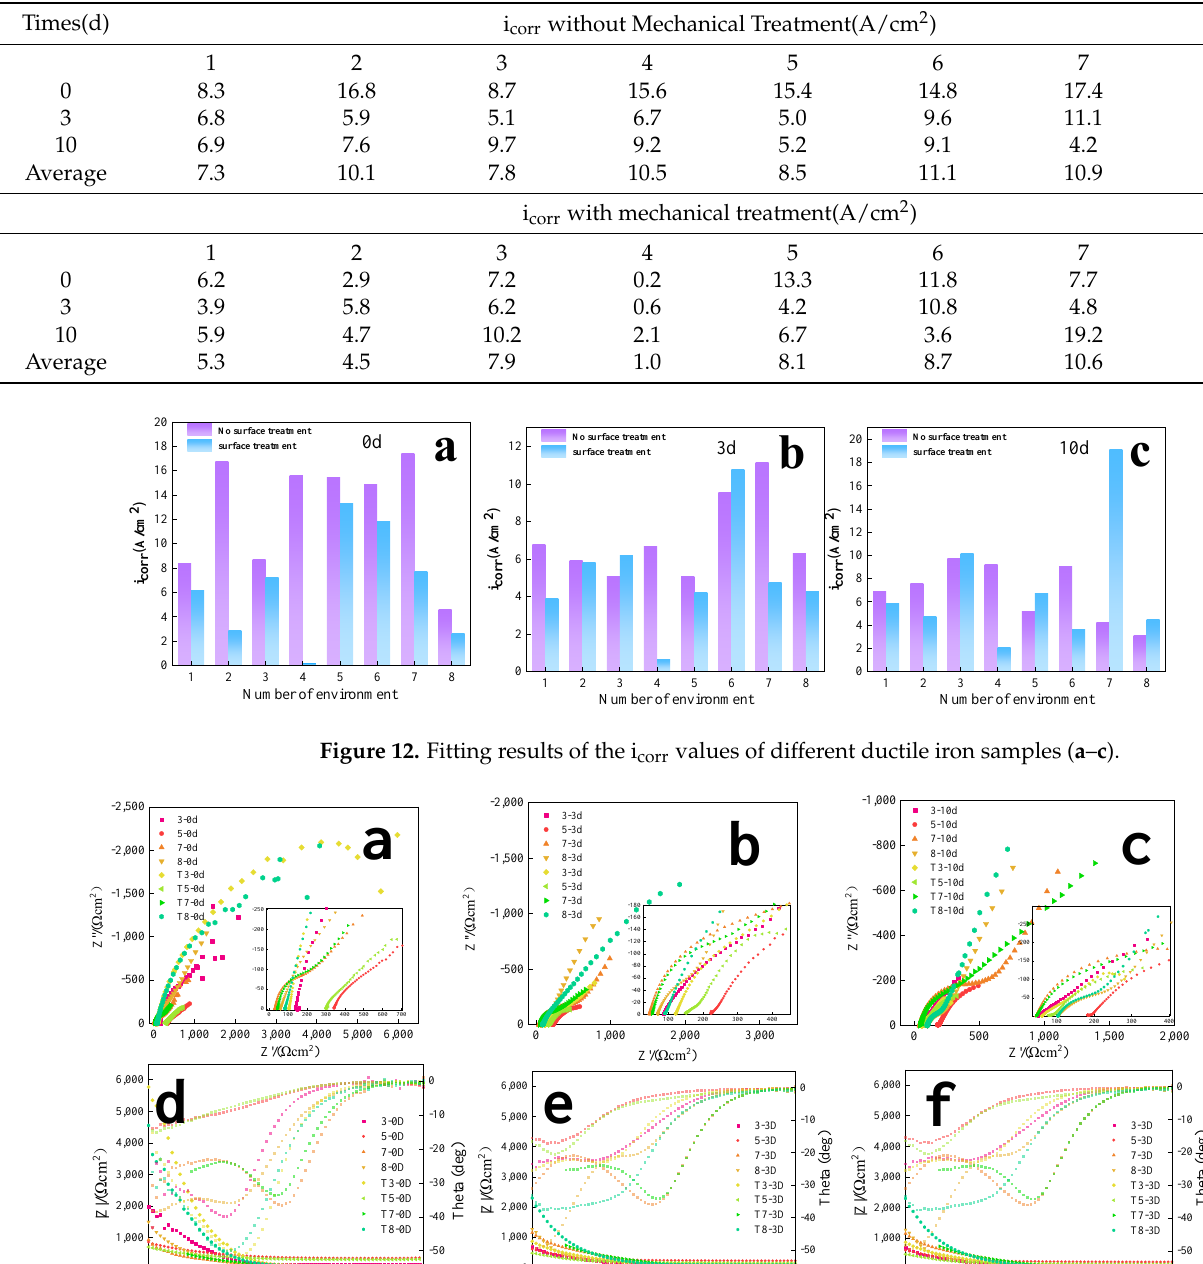
Table 2. Fitting results of i corr by potentiodynamic linear polarization scanning.